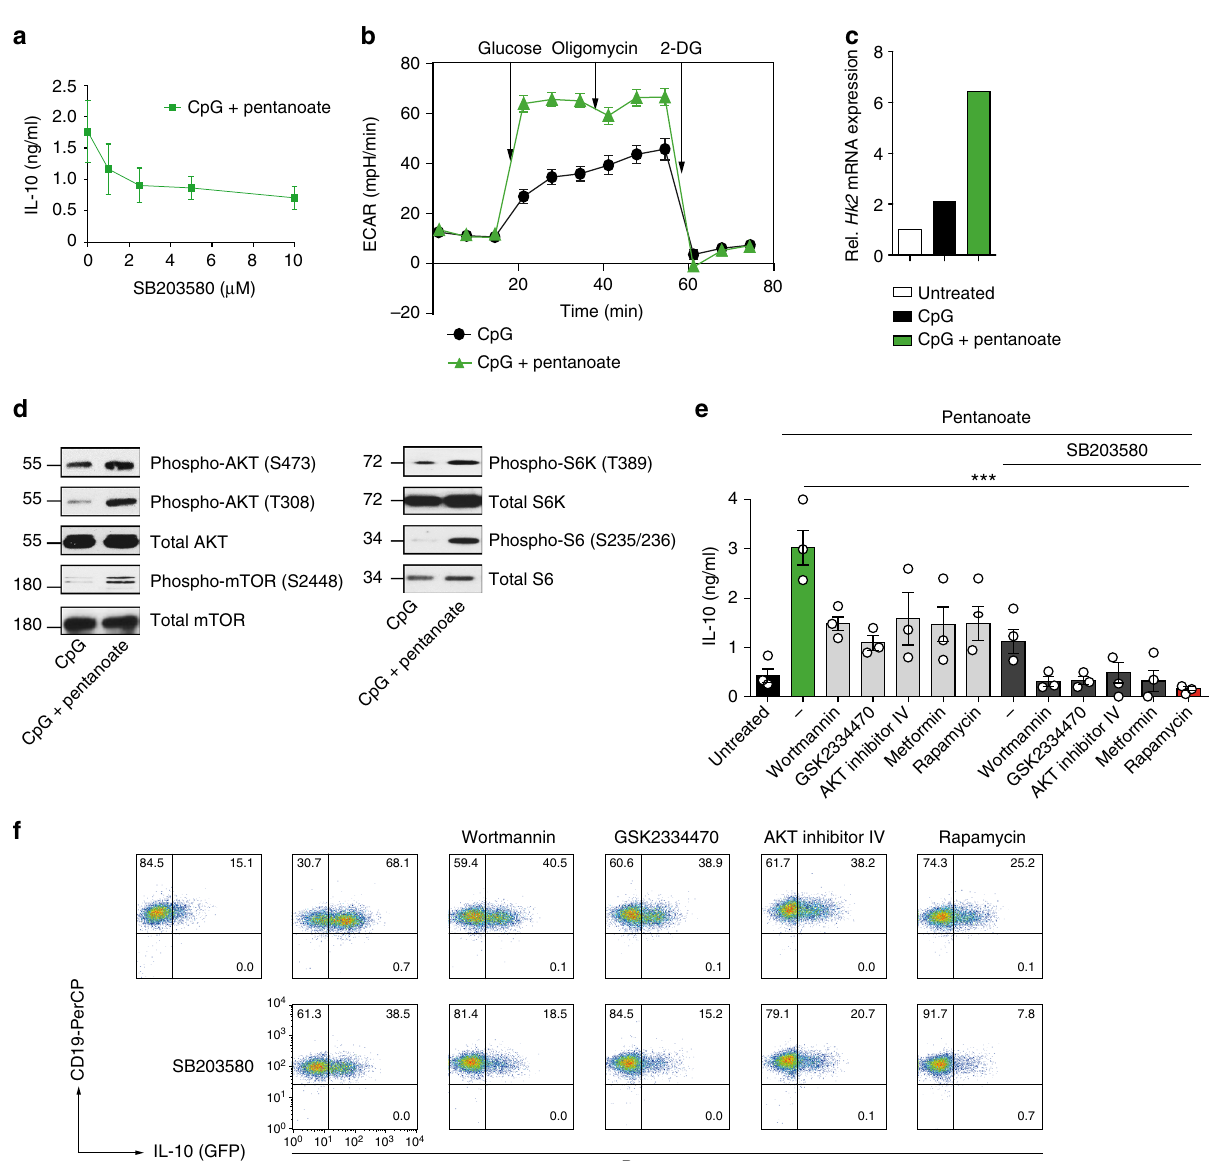
Fig. 5 Pentanoate-induced IL-10 expression in Bregs is dependent on glycolysis and p38 MAPK activity. a Bregs were generated with 4 μ g/ml CpG and 5 mM pentanoate in presence of increasing amounts of p38 inhibitor SB203580. IL-10 secretion was determined by ELISA. Three experiments were performed. b ECAR measurement of CpG-induced Bregs generated in the presence and absence of pentanoate. Three independent experiments were performed. c Bar graphs show Hk2 expression in pentanoate-treated Bregs on day 3 of the cell culture. One of three similar experiments is shown. d Immunoblot analysis of main components of AKT/mTOR signaling pathway in murine Bregs in the presence of pentanoate (5 mM). Three similar experiments were performed. e , f ELISA ( e ) and FACS analysis ( f ) of CD19 + IL-10 + Bregs generated with CpG and pentanoate in the presence of AMPK activator (metformin) or PI3K (wortmannin), PDK1 (GSK2334470), mTOR (rapamycin), and AKT (AKT inhibitor IV) inhibitors with or without SB203580. Three experiments were carried out. Error bars indicate SEM. *** P < 0.001 (Student's t CpG and pentanoate in the presence of increasing concentrations effector T cell numbers in colonic lamina propria and mesenteric of p38 inhibitor SB203580. After blocking the activation of p38 lymph nodes (mLN) were observed in the presence of kinase, pentanoate-generated Bregs still produced IL-10 to some pentanoate-treated Bregs (Supplementary Fig. 4e, f). These data extent, indicating that additional mechanisms are involved in the suggest that pentanoate but not butyrate might be therapeutically pentanoate-mediated modulation of Bregs (Fig. 5a). Interestingly, exploited for stabilizing suppressive phenotype of Bregs. many of the genes altered upon pentanoate treatment were related to metabolic pathways (Supplementary Fig. 5a, a complete list of metabolically-related genes was reported by us pre- Pentanoate-treated Bregs inhibit EAE development in mice . In viously 38 ). To test if pentanoate is capable of in fl uencing glyco- B cells, the activation of p38 mitogen-activated protein kinase lysis in B cells, we examined the ECAR in CpG-generated Bregs in (MAPK) signaling pathway leads to the induction of IL-10 the presence or absence of pentanoate. We observed that pen- expression 37 . To test a possible in fl uence of p38 on the tanoate treatment increased both glycolysis and glycolytic pentanoate-induced secretion of IL-10, we treated Bregs with